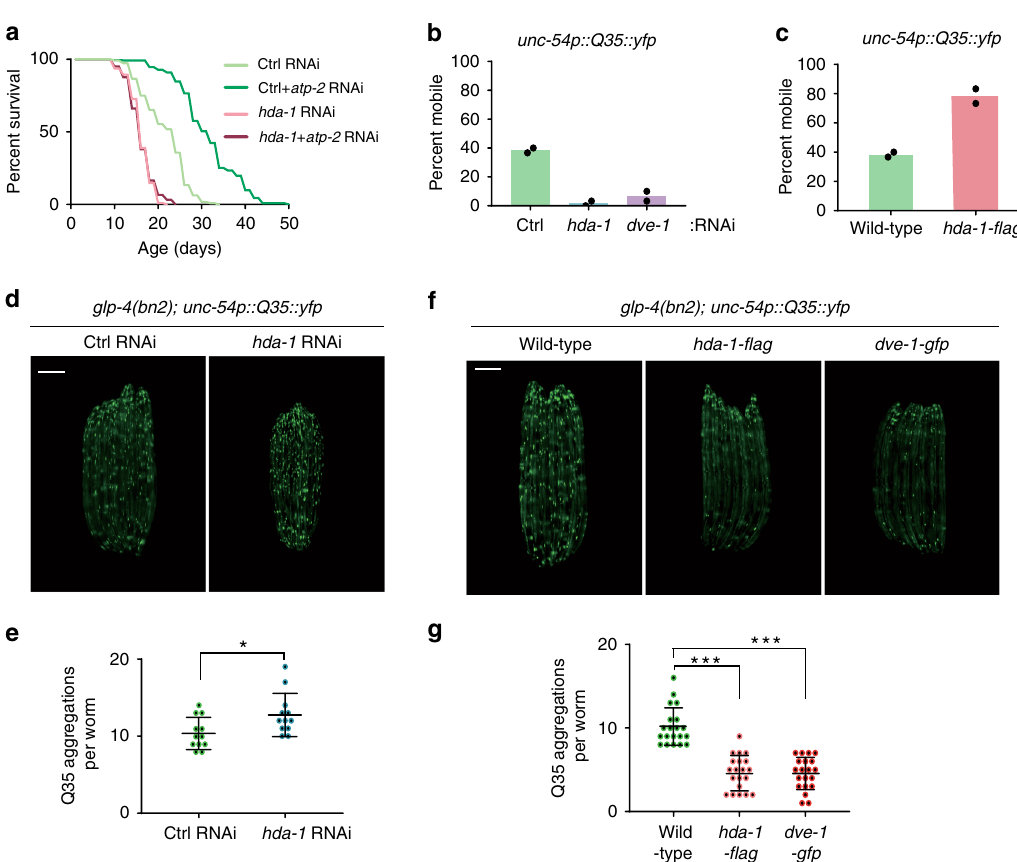
Fig. 4 HDA-1 affects animal aging and age-dependent accumulation of protein aggregates. a Lifespan analysis of worms raised on the indicated